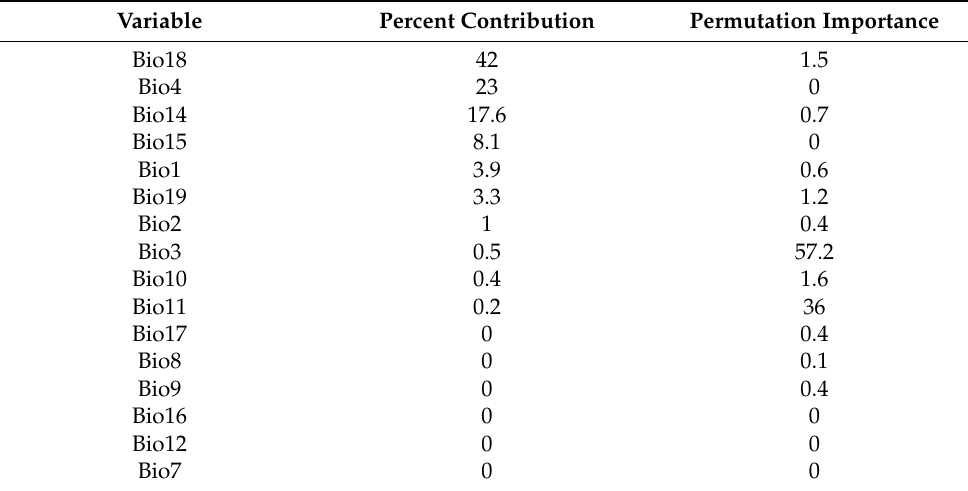
Table 2. The percentage contribution and permutation importance of environmental variables for predicting the distribution of Hippotiscus dorsalis . Variable Percent Contribution Permutation